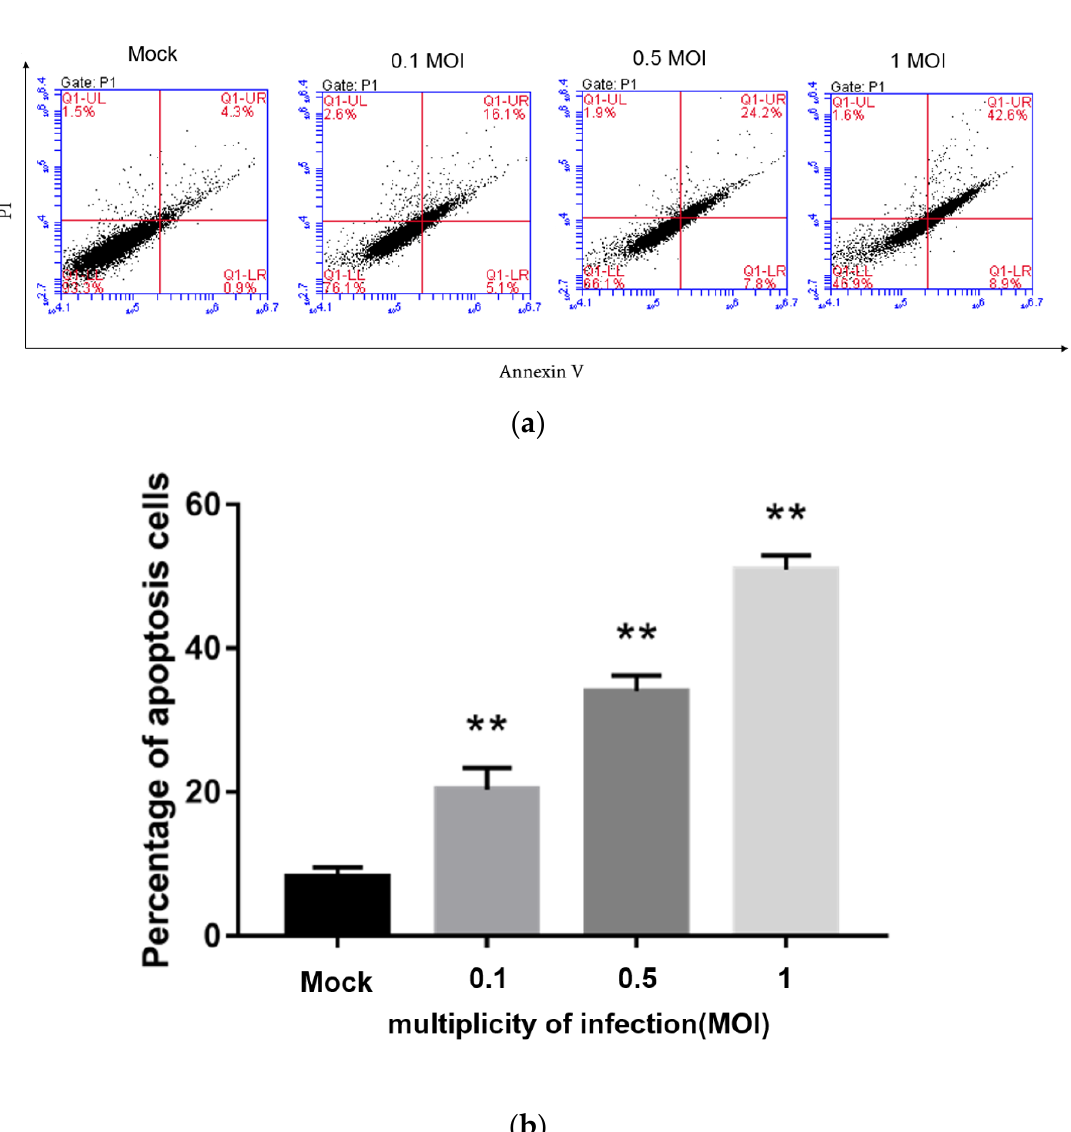
Figure 5. Detection of Vero cell apoptosis rate after PEDV infection by flow cytometry at different MOIs by Flow cytometry ( a ) and the percentage of apoptosis cells ( b ). **, p < 0.01.